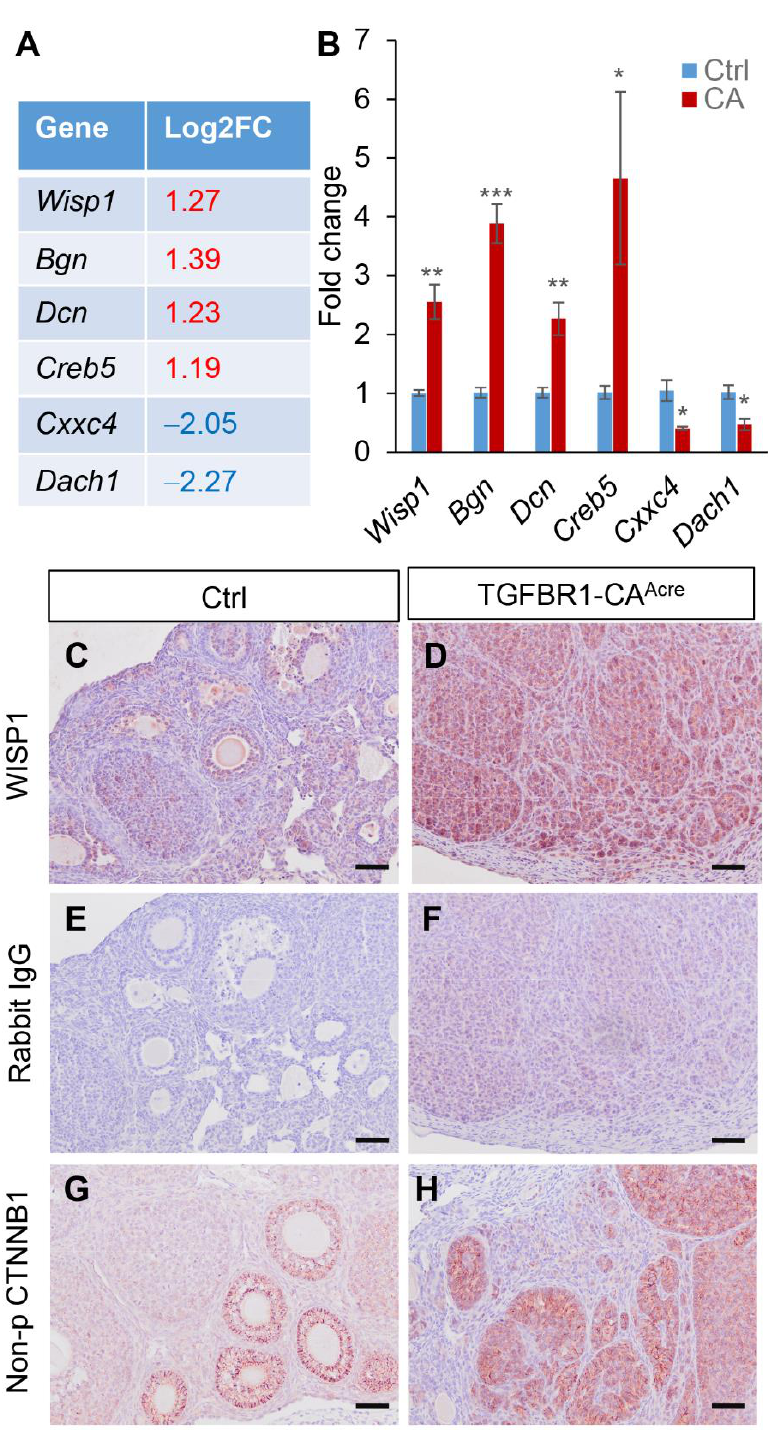
Figure 4. Upregulation of Wisp1 and WNT signaling activation in TGFBR1-CA ovaries. ( A ) Log 2 fold changes of a subset of WNT-related genes from RNA-seq analysis. ( B ) qRT-PCR analysis of Wisp1 , Bgn , Dcn , Creb5 , Cxxc4 , and Dach1 in ovaries from TGFBR1-CA and control mice at the age of 1 month. n = 4. * p -value < 0.05, ** p -value < 0.01, and *** p -value < 0.001. ( C – H ) Immunohistochemical staining of WISP1 and non-phospho CTNNB1 in ovaries from TGFBR1-CA and control mice at the age of 1 month. Isotype-matched rabbit IgG was included as a negative control. n = 3. Scale bar = 50 µm ( C – H ).